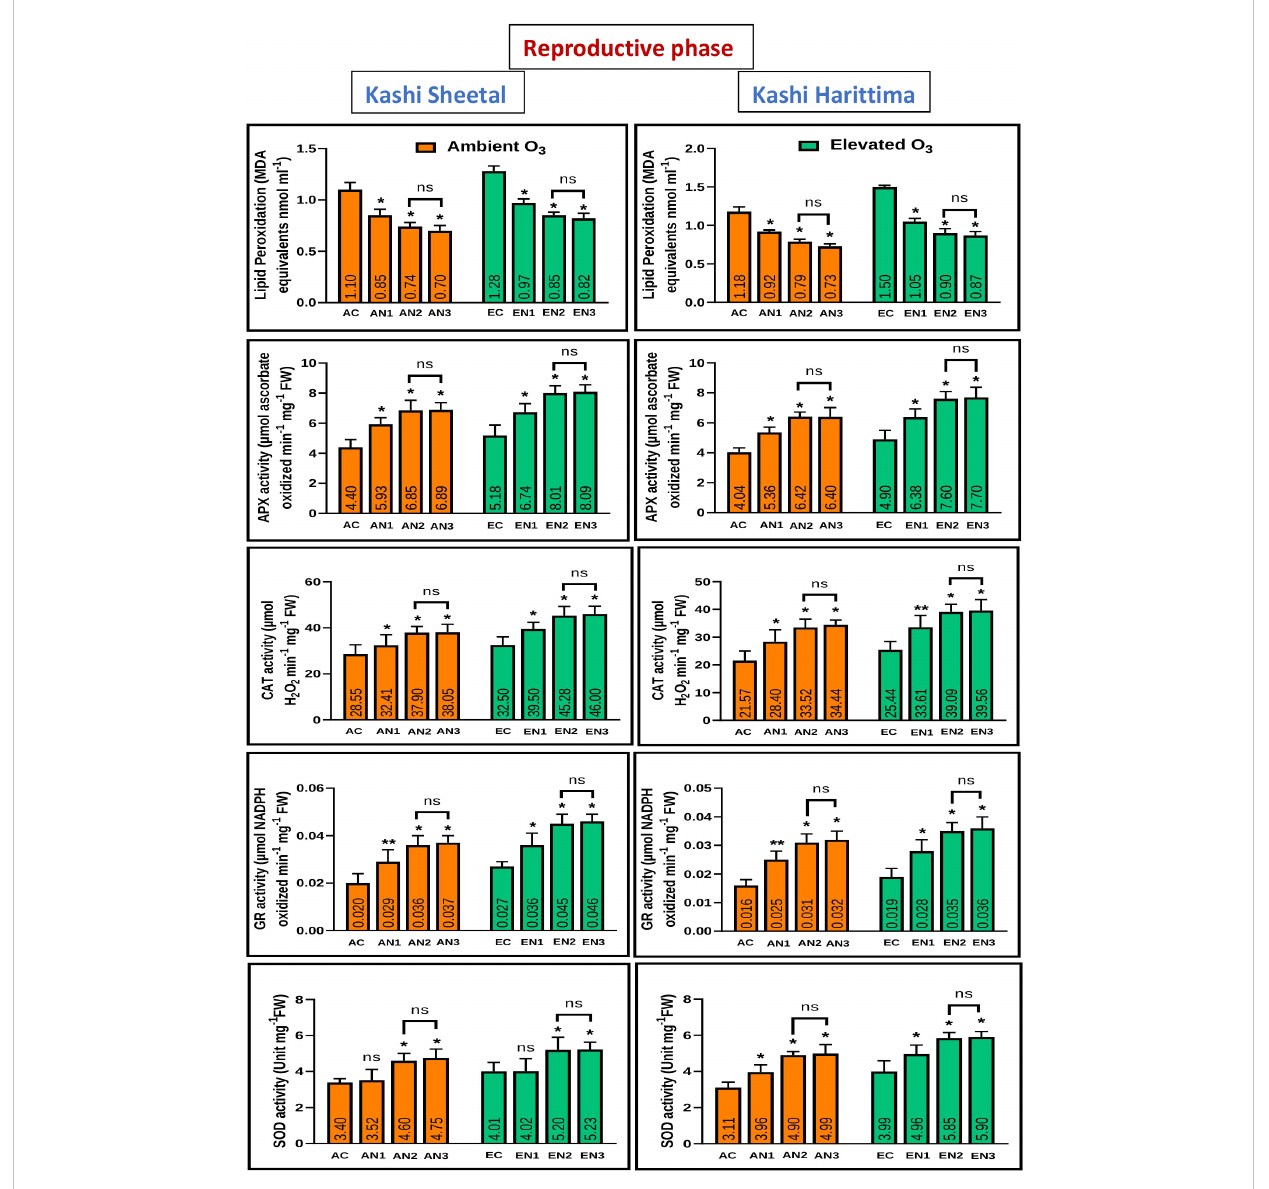
FIGURE 6 Variations in antioxidative enzymes in both varieties of Dolichos lablab L grown under AO 3 and EO 3 in the reproductive phase. Values are mean ± SE. Level of signi fi cance between AO 3 and EO 3 treated plants based on t-test; ns; not signi fi cant; *, P ≤ 0.05; **, P ≤ 0.01; ***, P ≤